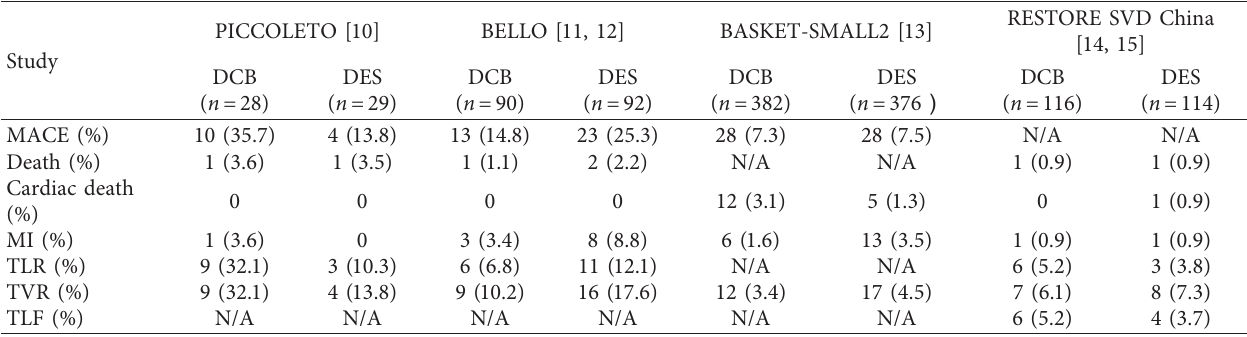
Table 2: Outcomes of included studies.